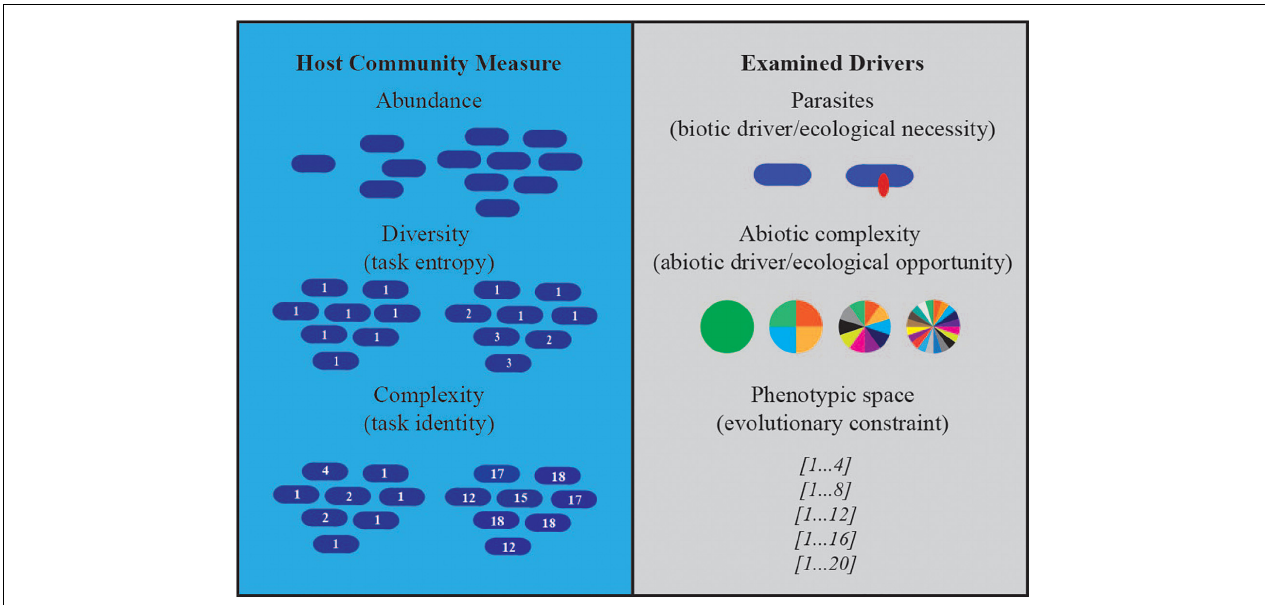
FIGURE 1 | Host community measures and examined drivers. Illustrations depict the three drivers we manipulated in our experiments and the effects on host communities we